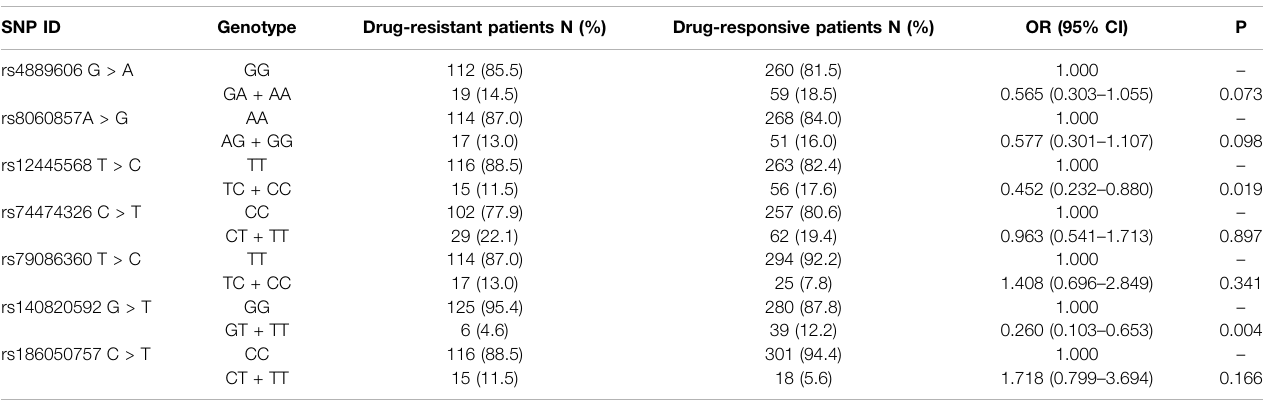
TABLE 5 | Associations between STX1B SNP genotypes and drug-resistant epilepsy.